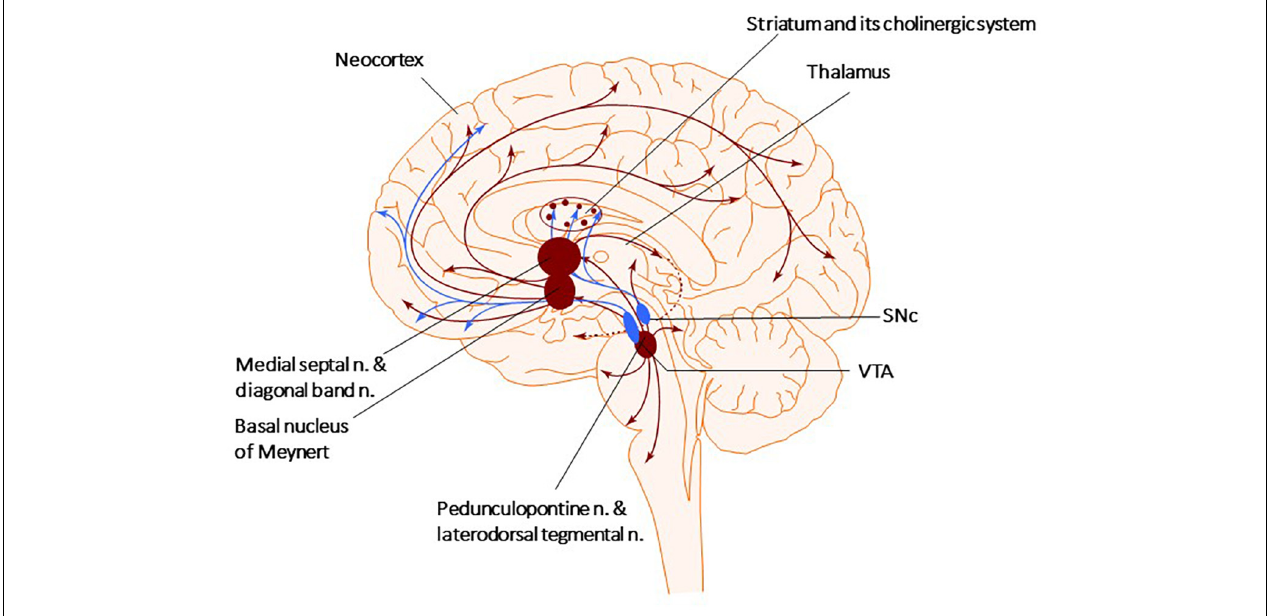
FIGURE 1 | Cholinergic and Dopaminergic systems. The diagram describes the Cholinergic (brown) and Dopaminergic (blue) systems. There are four primary sources of cholinergic projections in the mammalian brain. These include pedunculopontine nucleus and laterodorsal tegmental nuclei; a set of thalamic nuclei; striatum, where few cholinergic neurons are local interneurons; and the basal forebrain nuclei, which collectively serve as the primary sources of cholinergic projection neurons in the neocortex, hippocampus, and amygdala. SNc-Substantia nigra pars compacta, VTA, ventral tegmental area.